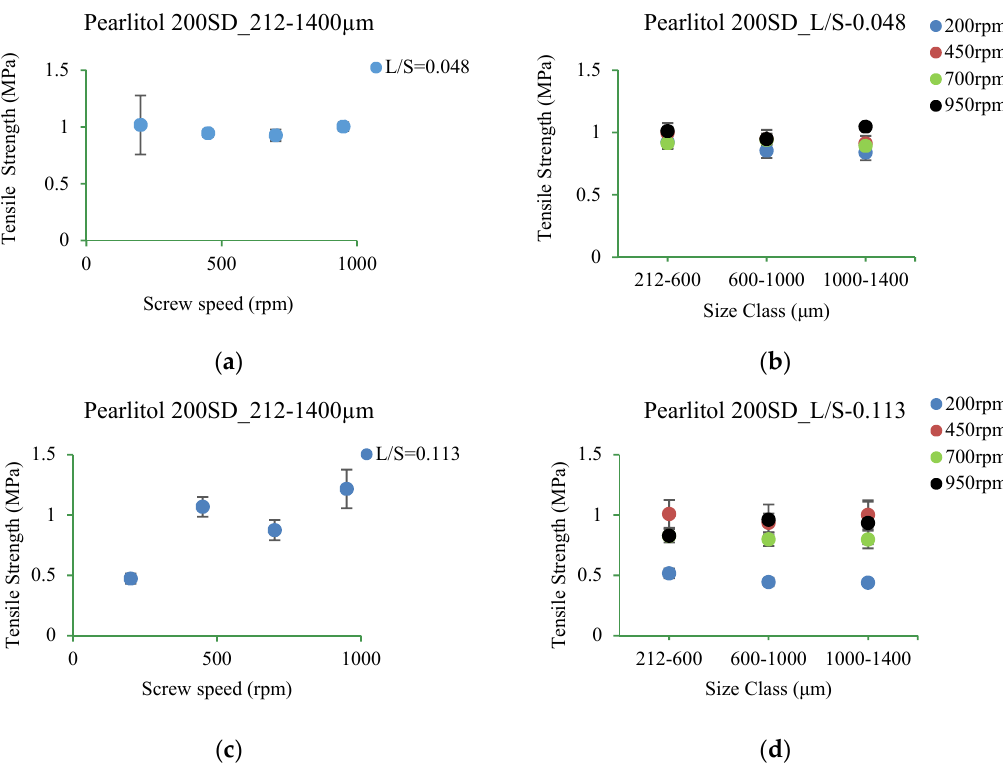
Figure 19. Tensile strength of tablet of granules at different size classes of Pearlitol 200SD. ( a ) 212–